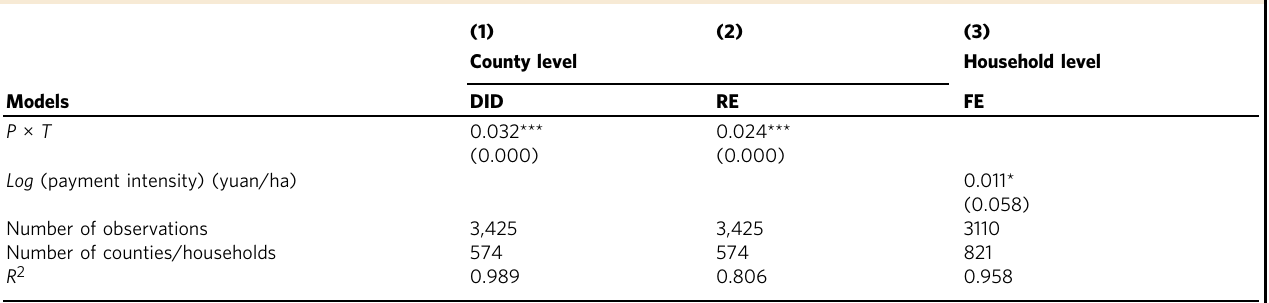
Table 1 Estimated impact of the Grassland Ecological Compensation Program (GECP) on grassland quality: county and household levels.